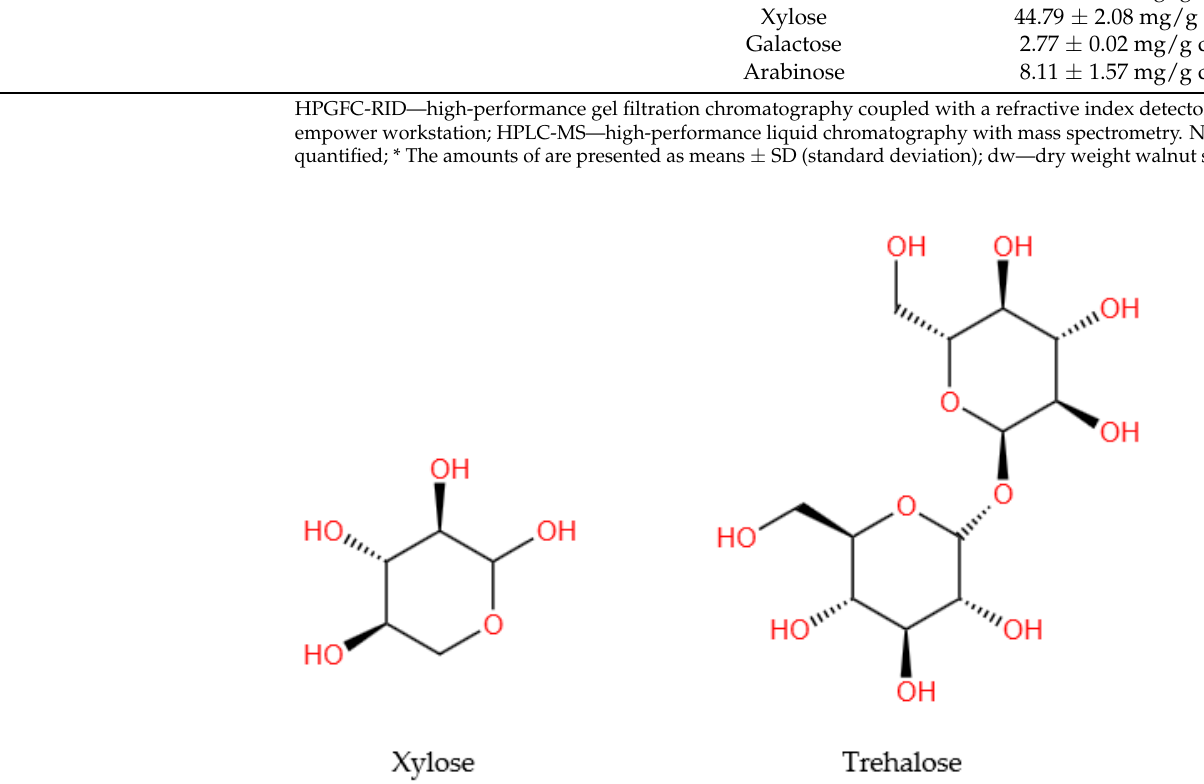
Figure 3. Chemical structures of the main carbohydrate compounds quantified in walnut septum.